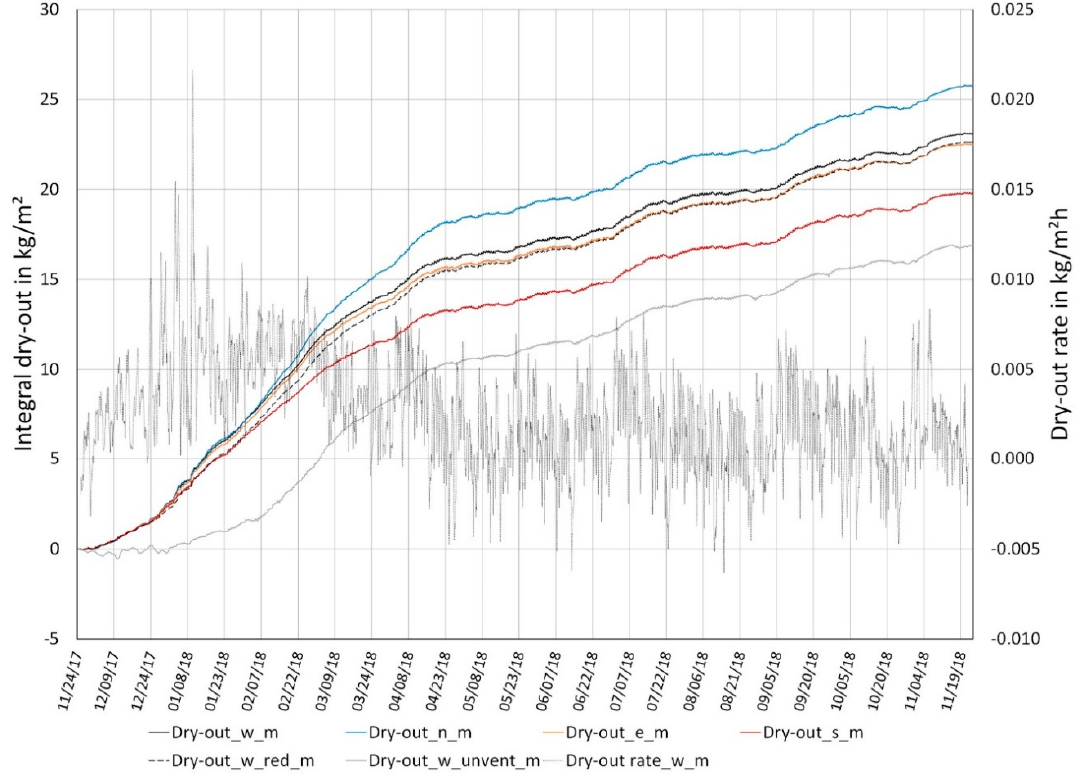
Figure 6. Integral dry-out for normal and reduced ventilation and dry-out rate.